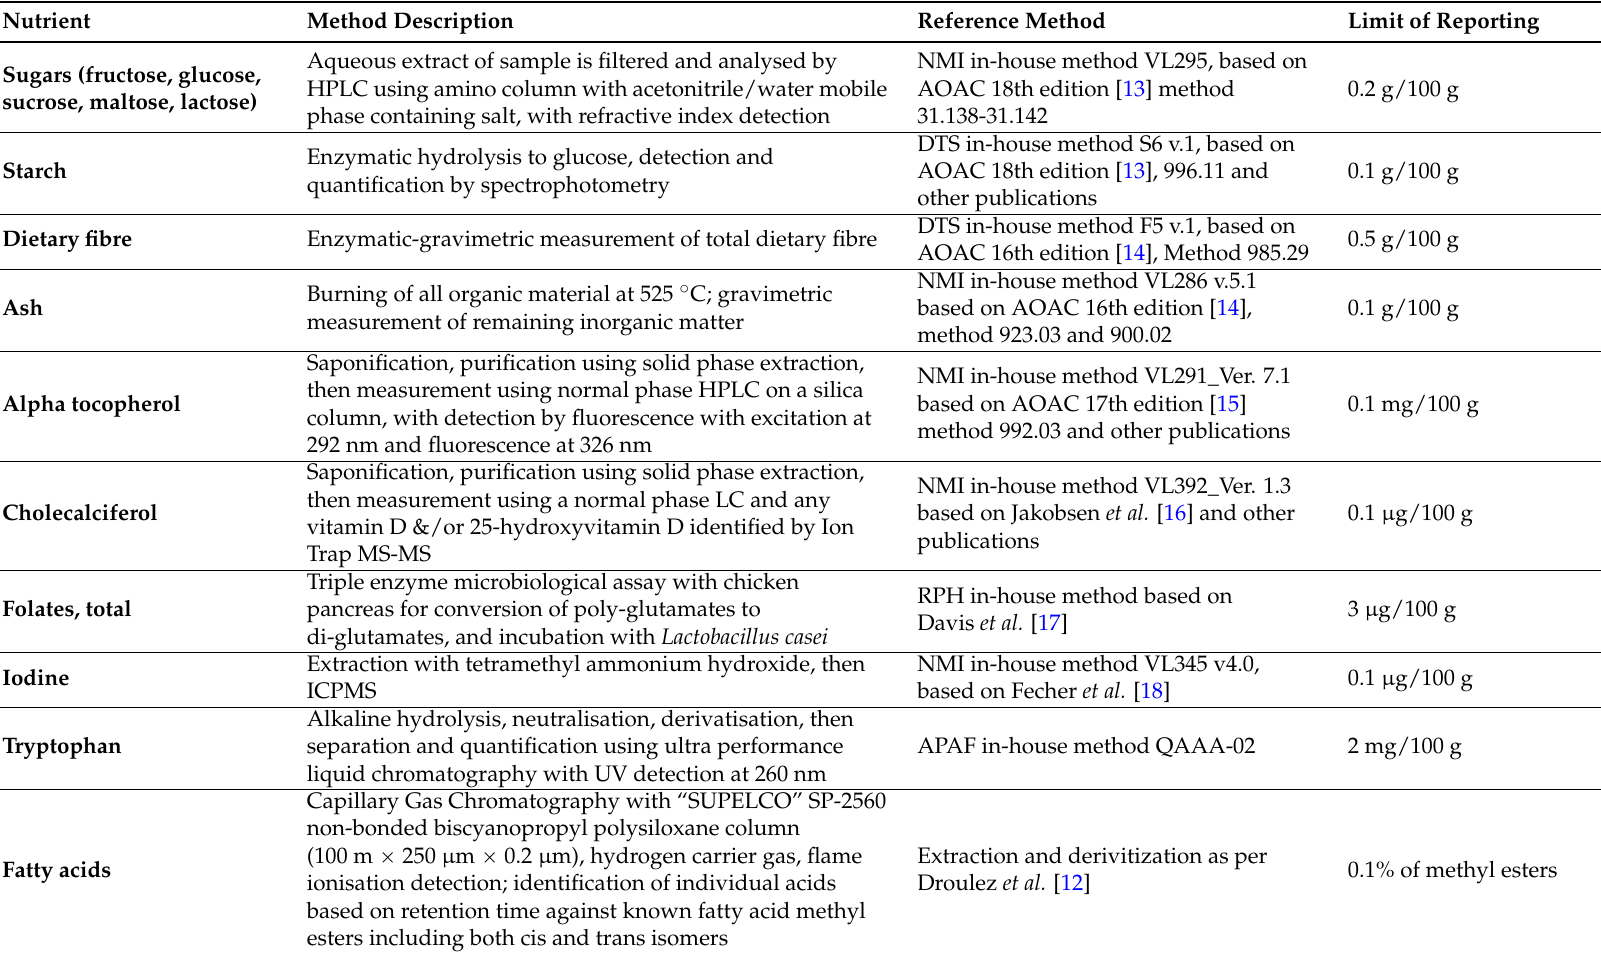
Table 1. Methods of analysis for analyses not described in Williams et al. (2007) [8] or Droulez et al. (2006)